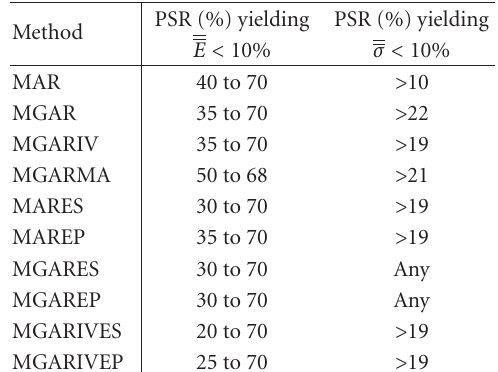
Table 6: PSR values at which acceptable results were obtained for both